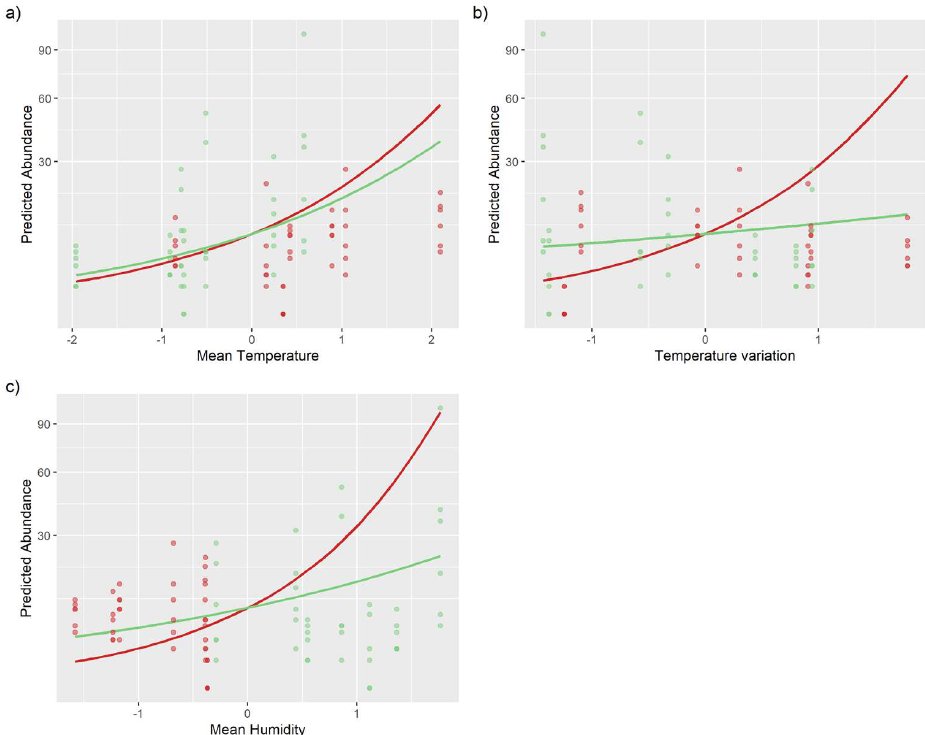
Figure 3. Effects of environmental variables that explained the abundance patterns of fruit-feeding butterfly assemblages sampled in mixed ombrophilous forest in southern Brazil during November 2016–March 2017 and October 2017–March 2018. Red colors indicate sites and regression lines related to the canopy, while green colors indicate sites and regression lines related to the understory. ( a ) Effects of mean temperature at day, highlighting the lack of interaction with the stratum. ( b ) Effects of the standard deviation of temperature at night and their dependency on the stratum. ( c ) Effects of the mean humidity at day on abundance, showing the positive relationship with the canopy. The y-axis was square-root-transformed for better visualization of the patterns. The predictor variables were scaled before performing the analysis to have a mean equal to 0 and a standard deviation equal to 1. Table 1. Model selection table for models for richness and abundance of fruit-feeding butterfly as- semblages sampled in mixed ombrophilous forest in southern Brazil during November 2016–March 2017 and October 2017–March 2018. In the null model, the response variables were modeled by 1, whereas, in the full model, they were modeled considering the environmental variables. We con- sidered the best model to have the lowest AICc and a delta < 2. 1 Pseudo-R 2 calculated using the trigamma method and considering both fixed and random effects (conditional). df logLik AICc Delta Weight Pseudo-R 2